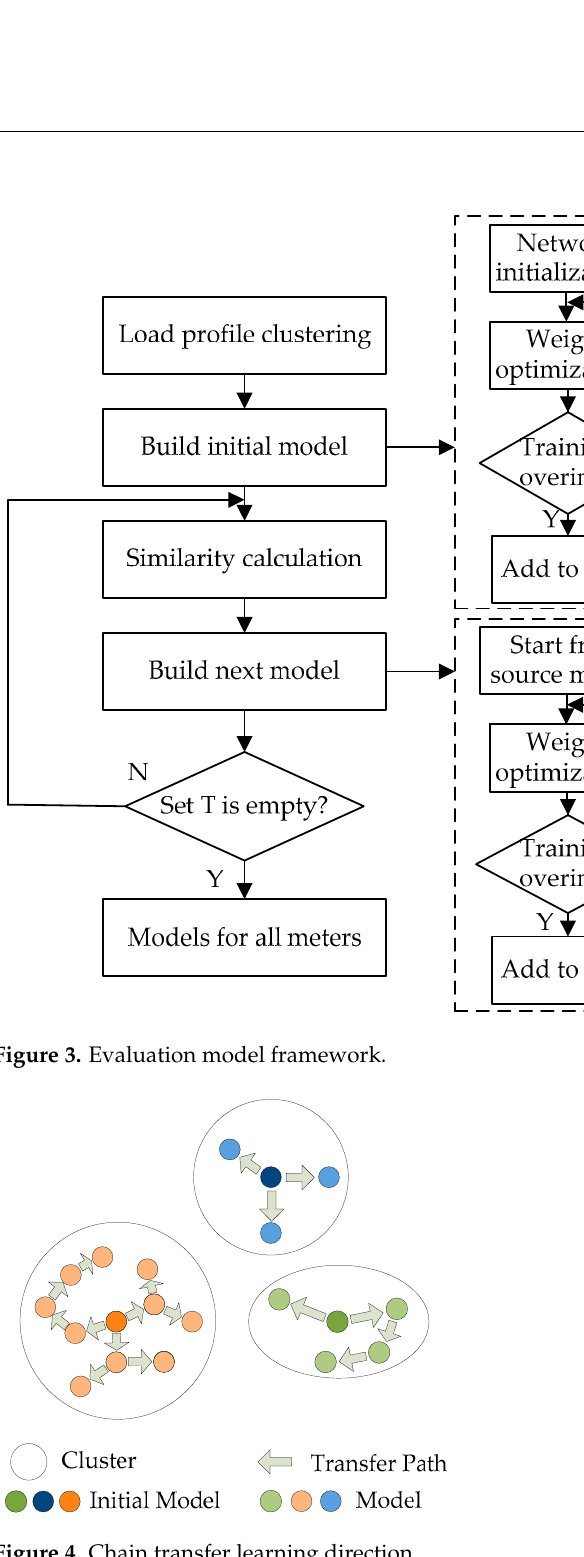
Figure 4. Chain transfer learning direction.